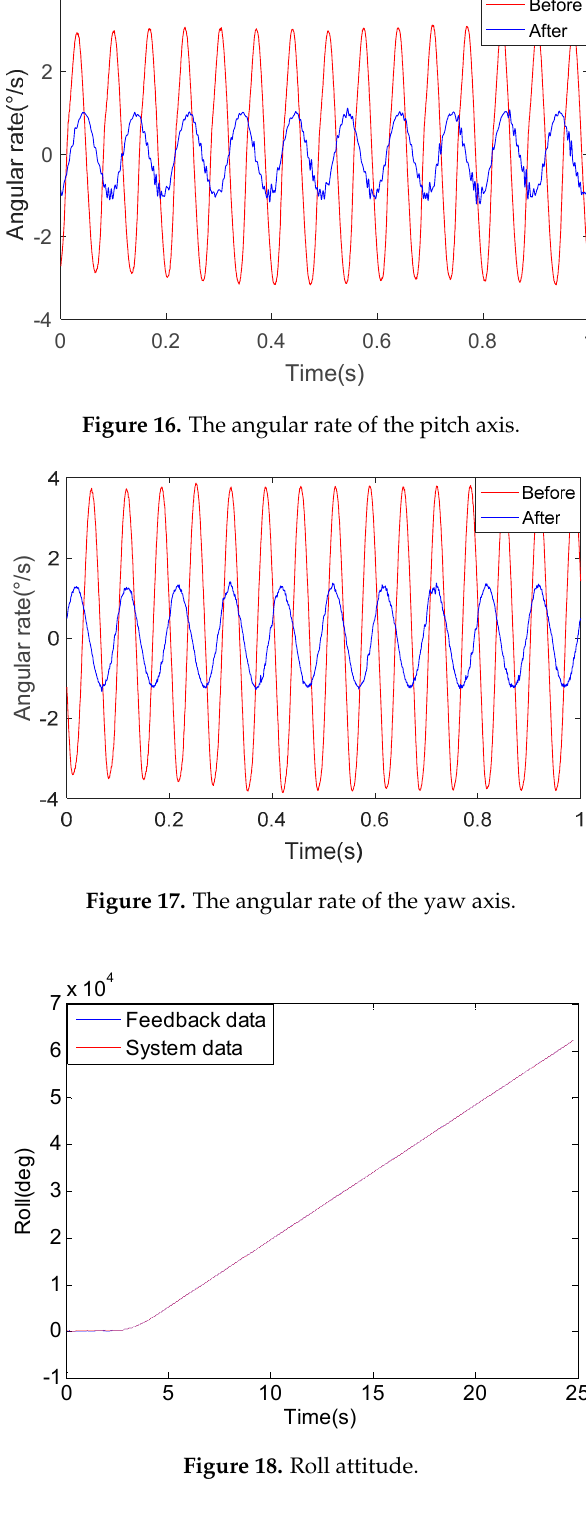
Figure 15. Angular rate in the direction of the roll axis.